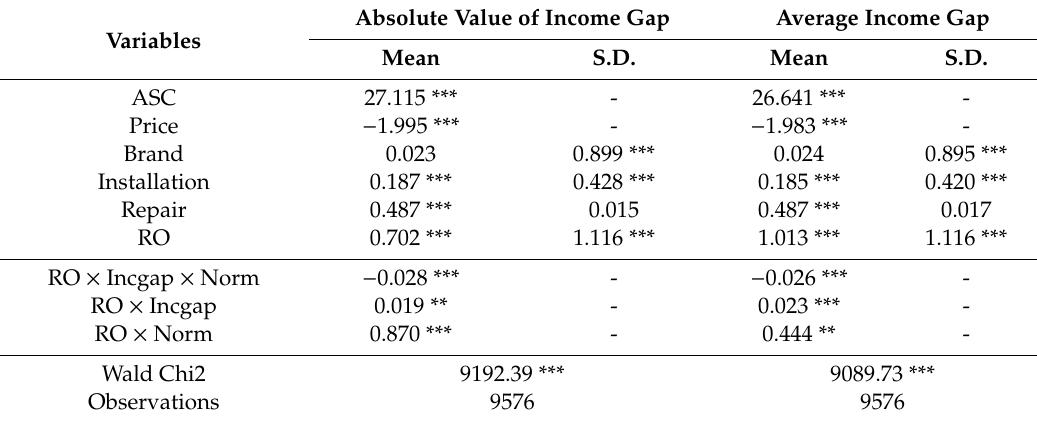
Table 8. The results of mechanisms on the average income